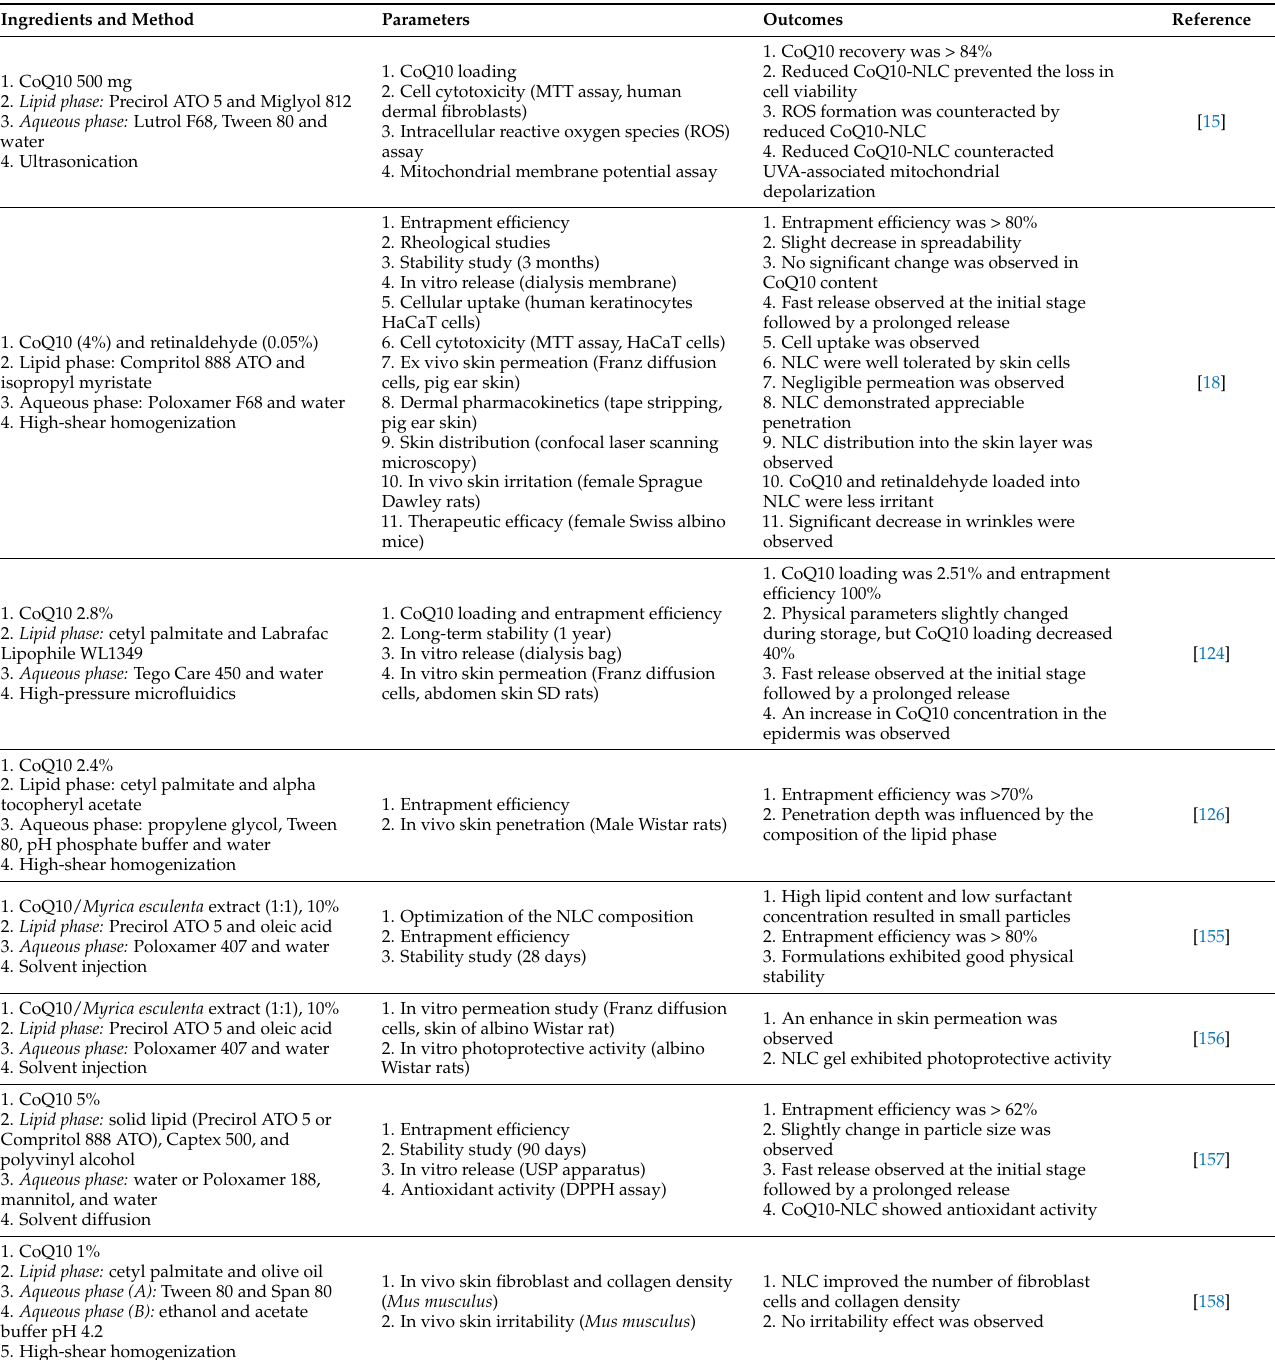
Table 7. An overview of CoQ10 encapsulation in nanostructured lipid carriers (NLC) employing other preparation methods. Ingredients and